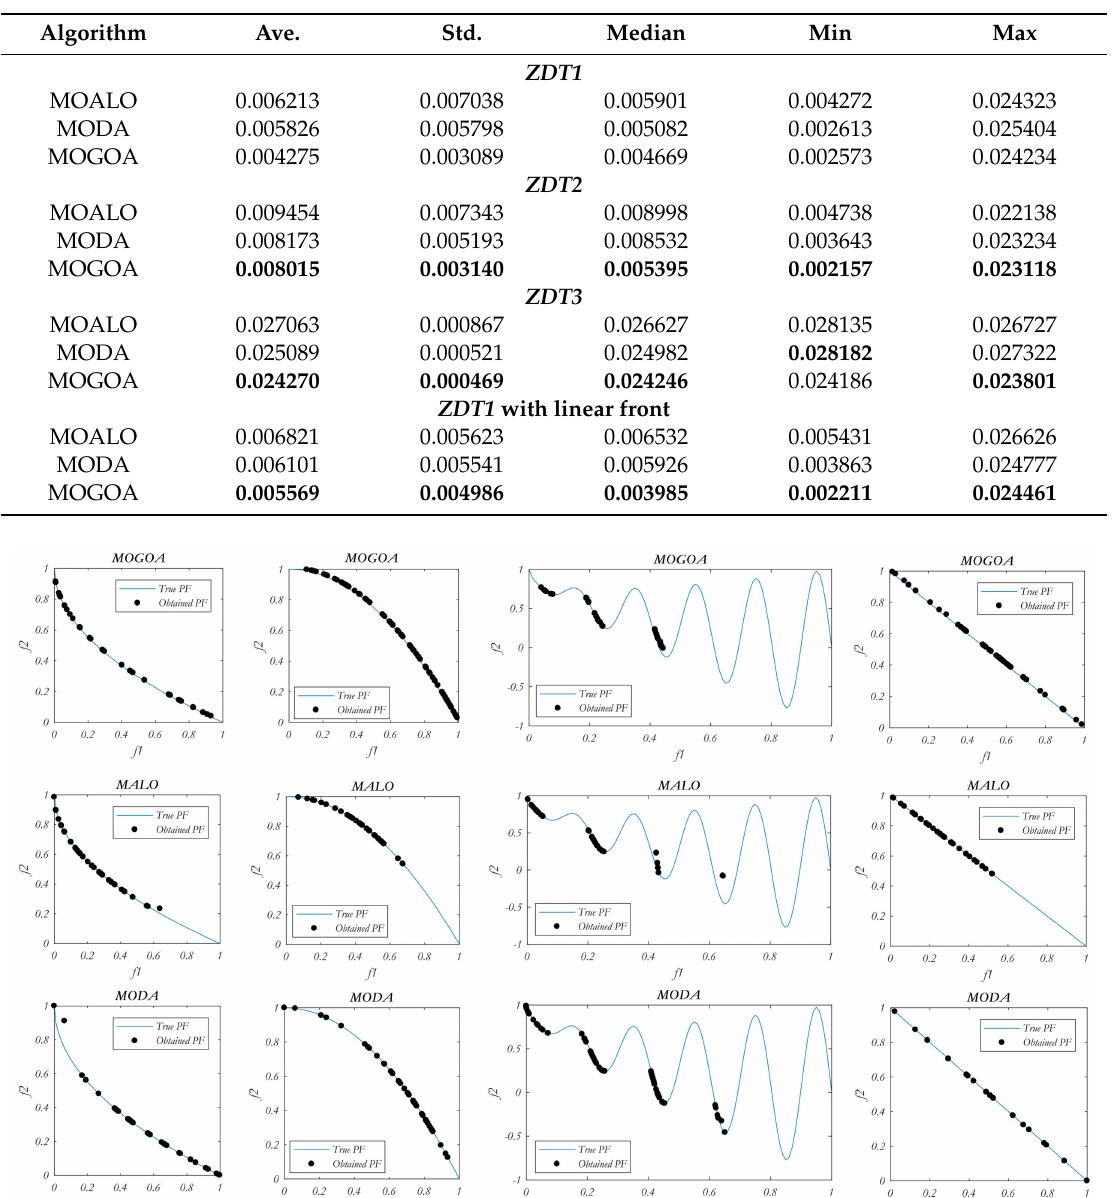
Table 7. Results of multiobjective algorithms using inverted generational distance (IGD) on four test functions.